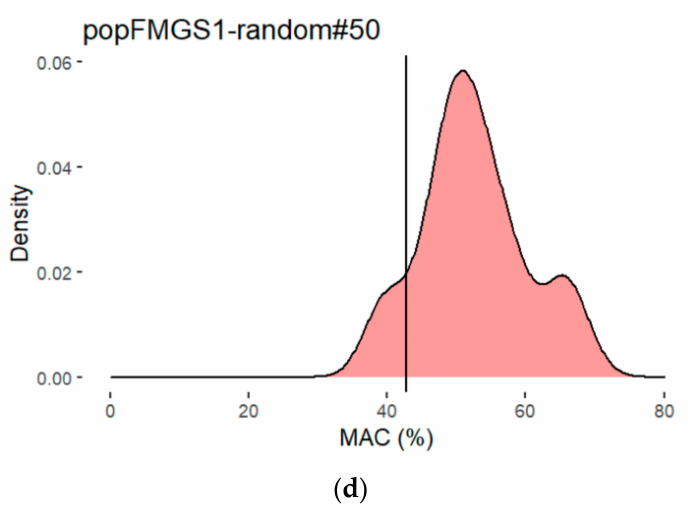
Figure 1. Malic acid consumed (MAC) at the end of alcoholic fermentation in a merlot grape juice. ( a ) Phenotypic distribution of 31 starters and relative position of the 4 founder strains SB, GN, M2, F15 (data previously published by [52]). ( b ) Phenotypic distribution of SBxGN hybrid and 94 related progeny clones including GS-28B (data previously published [46]). ( c ) Phenotypic distribution of M2xF15 hybrid and 96 related progeny clones including FM-8D (this work). All fermentations were carried out in the same conditions. ( d ) Phenotypic distribution of FMGS1 hybrid and 50 related progeny clones. The vertical bar indicated the value of the F1-hybrid of each